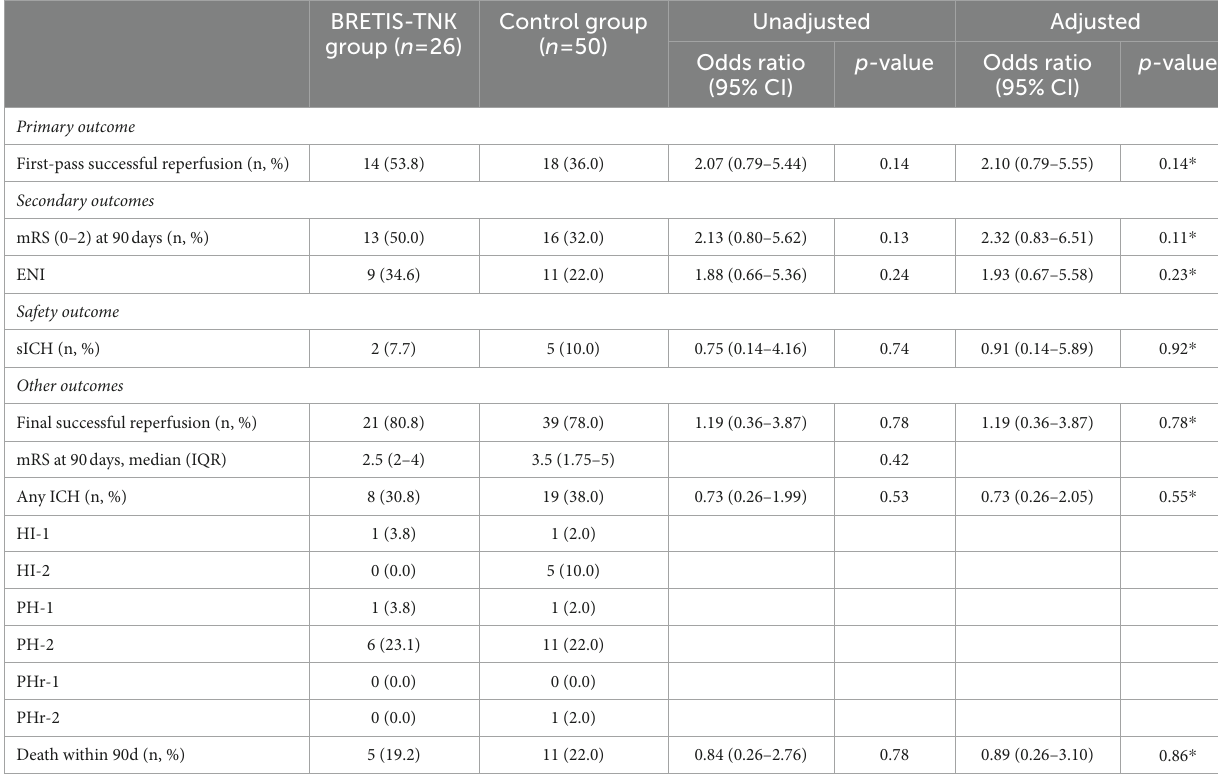
TABLE 2 Outcomes.